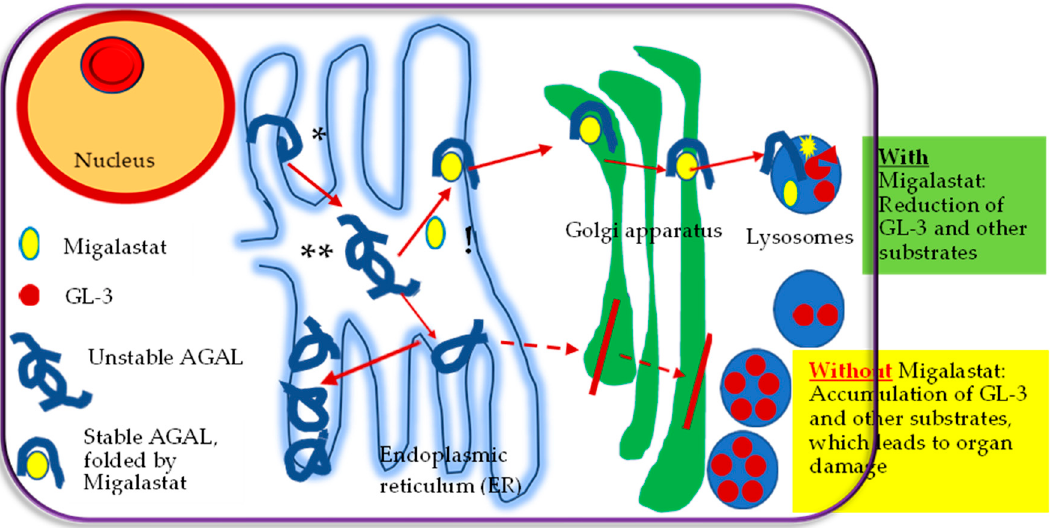
Figure 1. Overview of action of Migalastat. AGAL, alpha-galactosidase A. GL-3, Globotriaosylceramide. (*) Synthesis of misfolded AGAL. (**) Accumulation of misfolded AGAL.